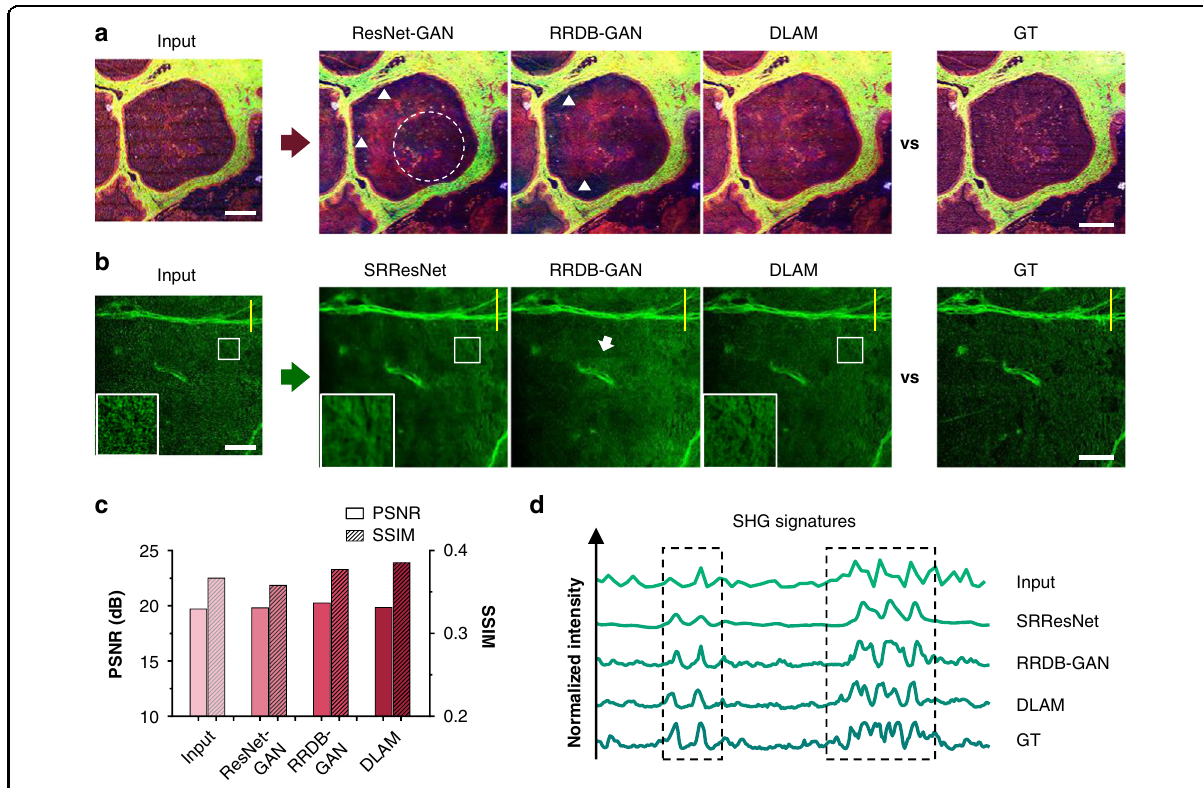
Fig. 5 Comparison of DLAM results against other deep networks. Additionally, see Figs. S13 and 14. a Label-free multimodal images and corresponding reconstruction images of a carcinomatous atretic follicle. White dashed circles and triangles indicate slight and obvious reconstruction artifacts, respectively. b SHG (with 3PA FAD crosstalk 4 ) images of collagen fi bers and carcinoma cells. White squares indicate ROIs magni fi ed in the insets. The white arrow indicates the discontinuity in the stitching. c PSNR and SSIM for different network outputs. d Intensity pro fi les along the yellow lines in ( b ). Black dashed squares indicate the SHG signatures. Scale bars, 300 μ m in a and 150 μ m in ( b